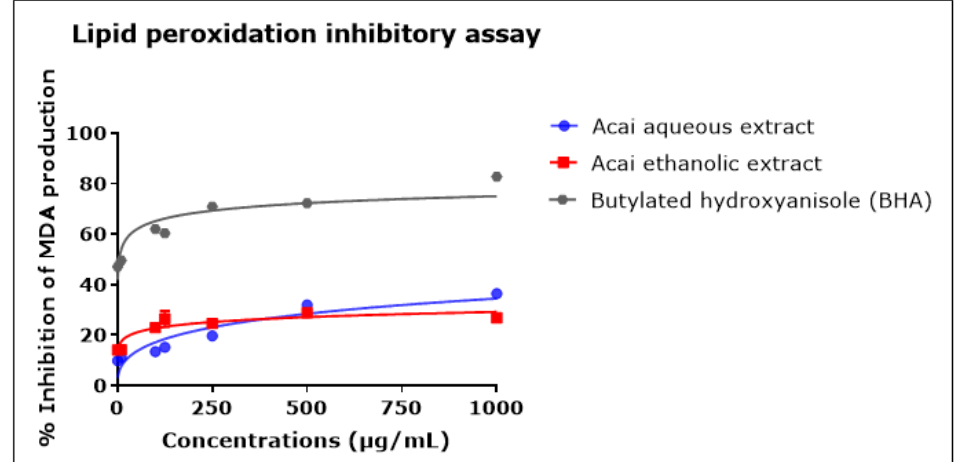
Figure 7. Lipid peroxidation inhibitory activity of acai aqueous and ethanolic extracts. Acai antioxidant activity was assessed via the percentage of the inhibition of malondialdehyde (MDA) production. Assays were performed in triplicate at each extract concentration ( n = 6). The IC 50 values for each of the cholinesterase and antioxidant assays are included in